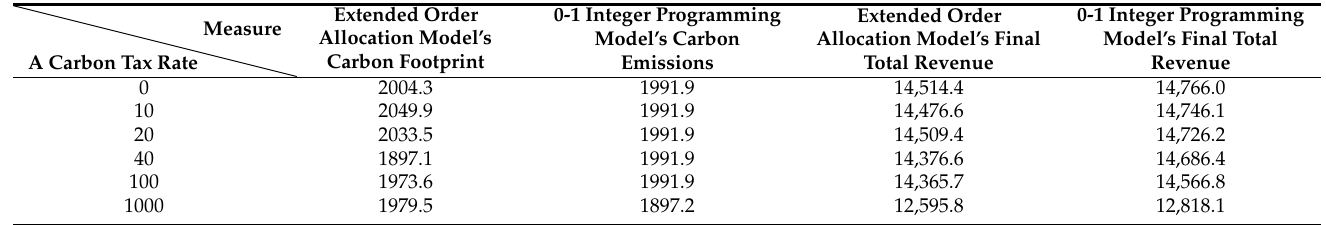
Table 7. Comparison between the extended order allocation model and the 0-1 integer programming model.